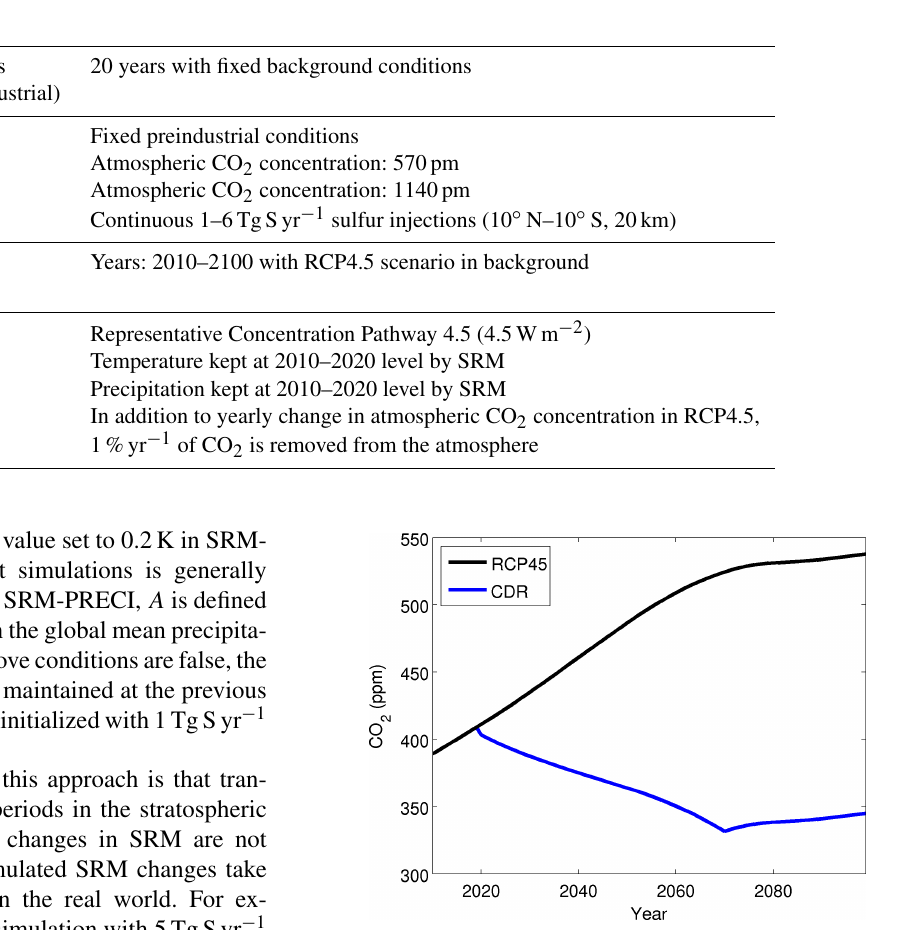
Figure 1. Atmospheric carbon dioxide concentration in scenarios RCP4.5 and